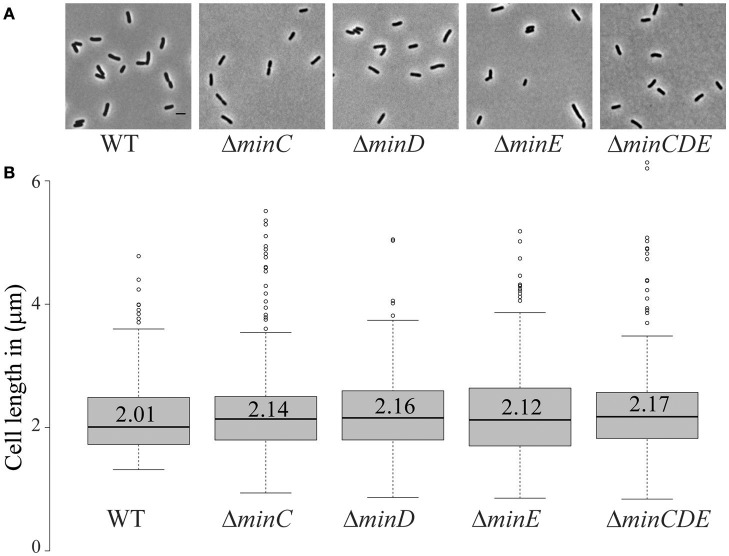
Short cells accumulate in min mutants. (A) Phase contrast images of representative wildtype and min mutant cells. Scale bar = 2 μm. (B) Box plots illustrate cell length distributions of wildtype cells and min mutants. Medians are shown by the labeled center lines. Box limits indicate the 25th and 75th percentiles as determined by R software; whiskers extend 1.5 times the interquartile range and outliers are represented by dots. Cell lengths measured from 948 cells for each strain.